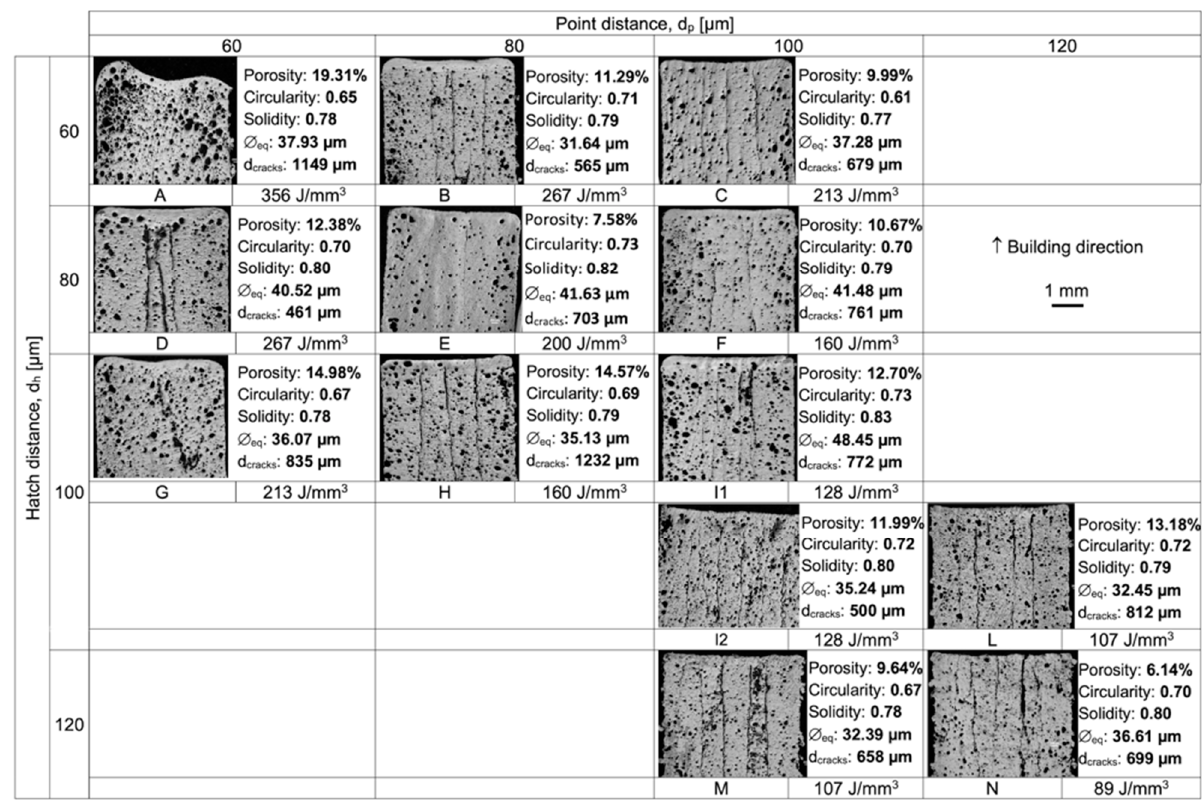
Figure 4. Optical micrographs, process parameters (hatch distance and point distance) and features of samples (porosity, circularity, solidity, equivalent diameter ∅ eq , and crack density d crack s ). Shown sections are parallel to building direction